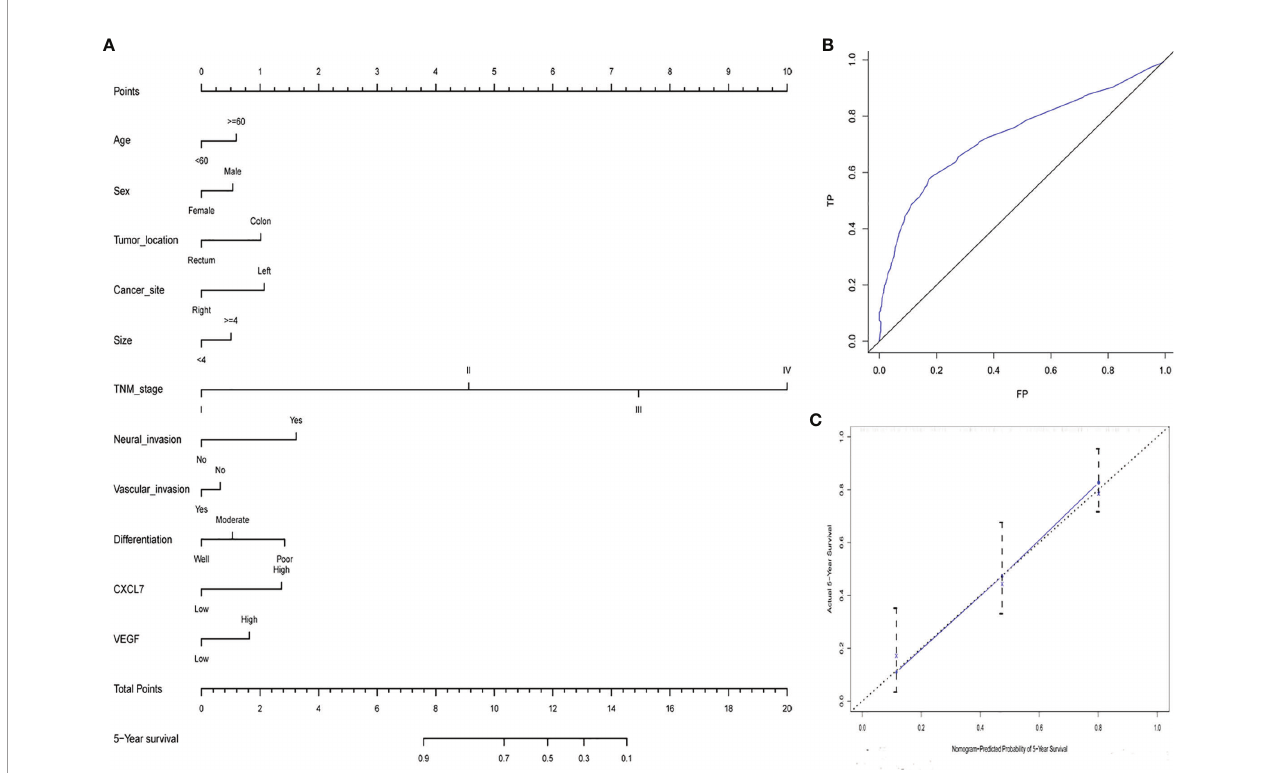
FIGURE 5 | Nomogram of CRC patients ’ 5-year survival time following surgery. (A) Nomogram for 5 ‐ year OS on the basis of CXCL7 and VEGF expression and basic clinical data. (B) ROC curve for developing the nomogram. (C) Calibration curve of the